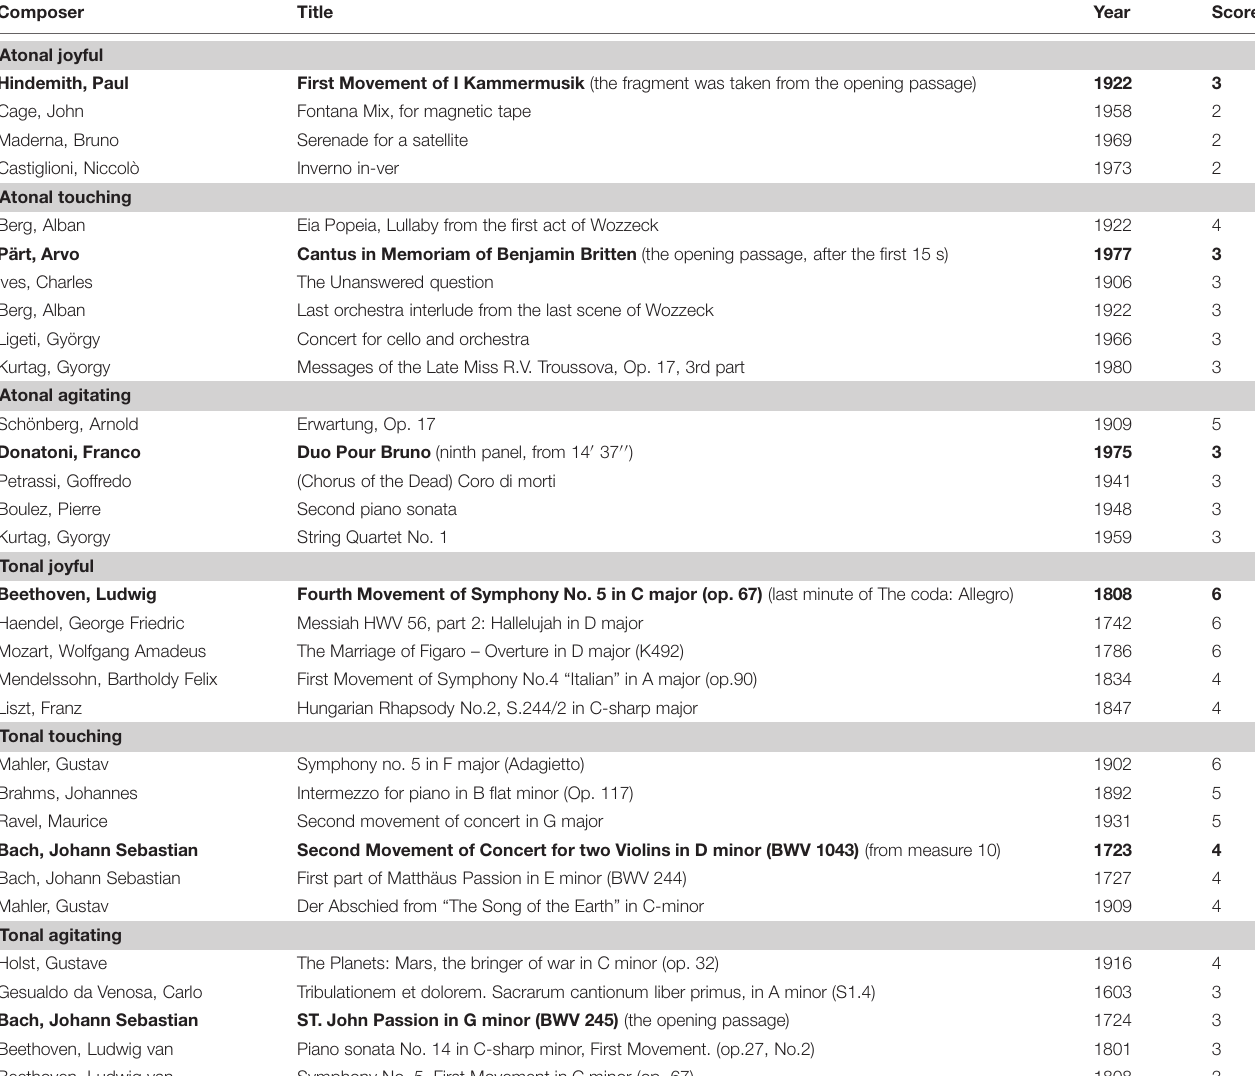
TABLE 1 | List of musical pieces selected more frequently and coherently by judges to represent each stylistic and affective